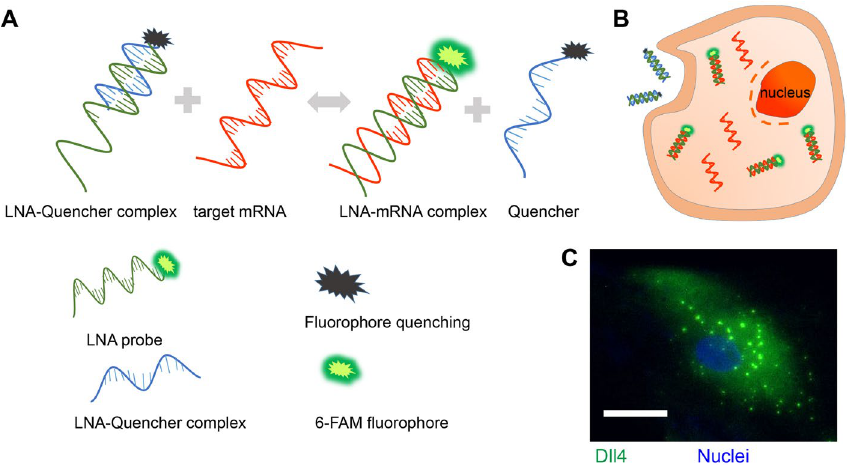
Figure 1. LNA/DNA nanobiosensor for single cell gene expression analysis in living cells. ( A ) Schematic illustration of LNA/DNA nanobiosensor for mRNA detection. Briefly, the LNA/DNA nanobiosensor is a complex of LNA donor and quencher probe. The fluorophore at the 5 ′ of LNA donor probe is quenched due to close proximity. In the presence of target mRNA sequence, the LNA donor sequence is displaced from the quencher to bind to the target sequence, allowing the fluorophore to fluorescence. ( B ) Schematic illustration of cellular endocytic uptake of LNA/DNA nanobiosensor by cells for intracellular gene detection. ( C ) Representative fluorescence image of Dll4 mRNA expression in single hMSC using LNA/DNA nanobiosensor. Green: Dll4 mRNA; blue: Nuclei. Scale bar: 25